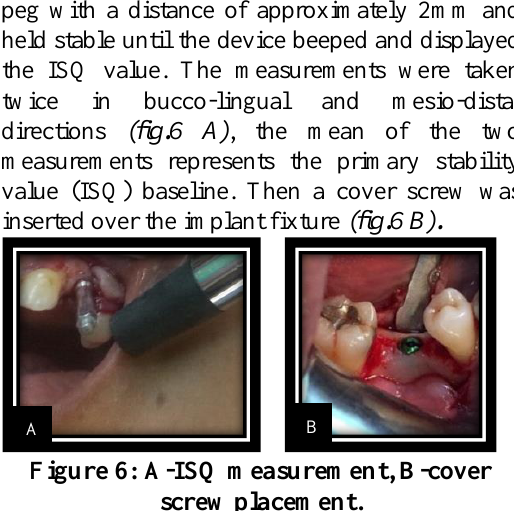
Figure 6: A-ISQ measurement, B-cover screw